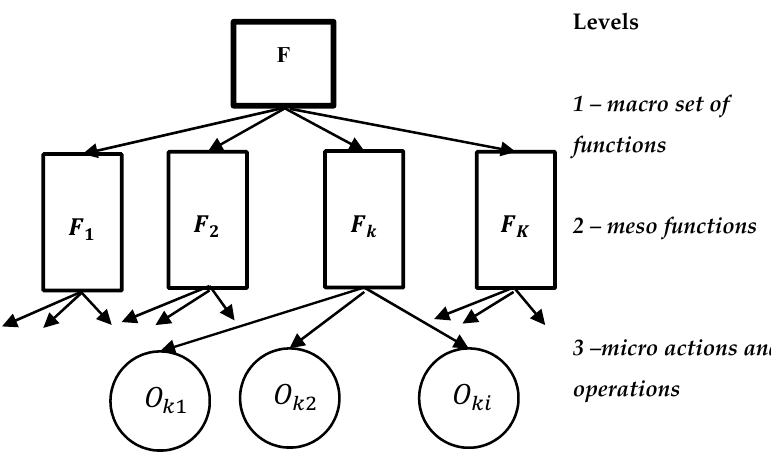
Figure 5. A graph of functions, actions and operations.